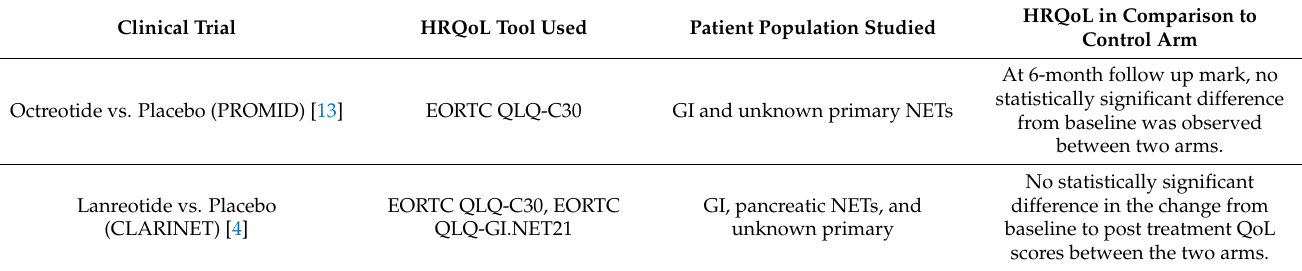
Table 2. Health-related quality of life in phase III neuroendocrine tumor